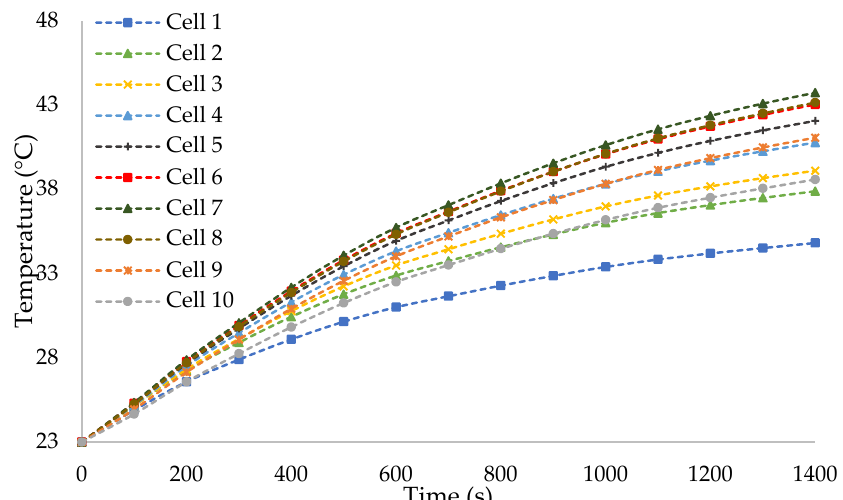
Figure 5. The simulation results of the module when using ACTMS as a cooling solution, this is the main case study with inlet air velocity of V = 3 m/s, no gap spacing between the neighboring cells, inlet air temperature of 23 °C, and environment temperature of 23 °C.